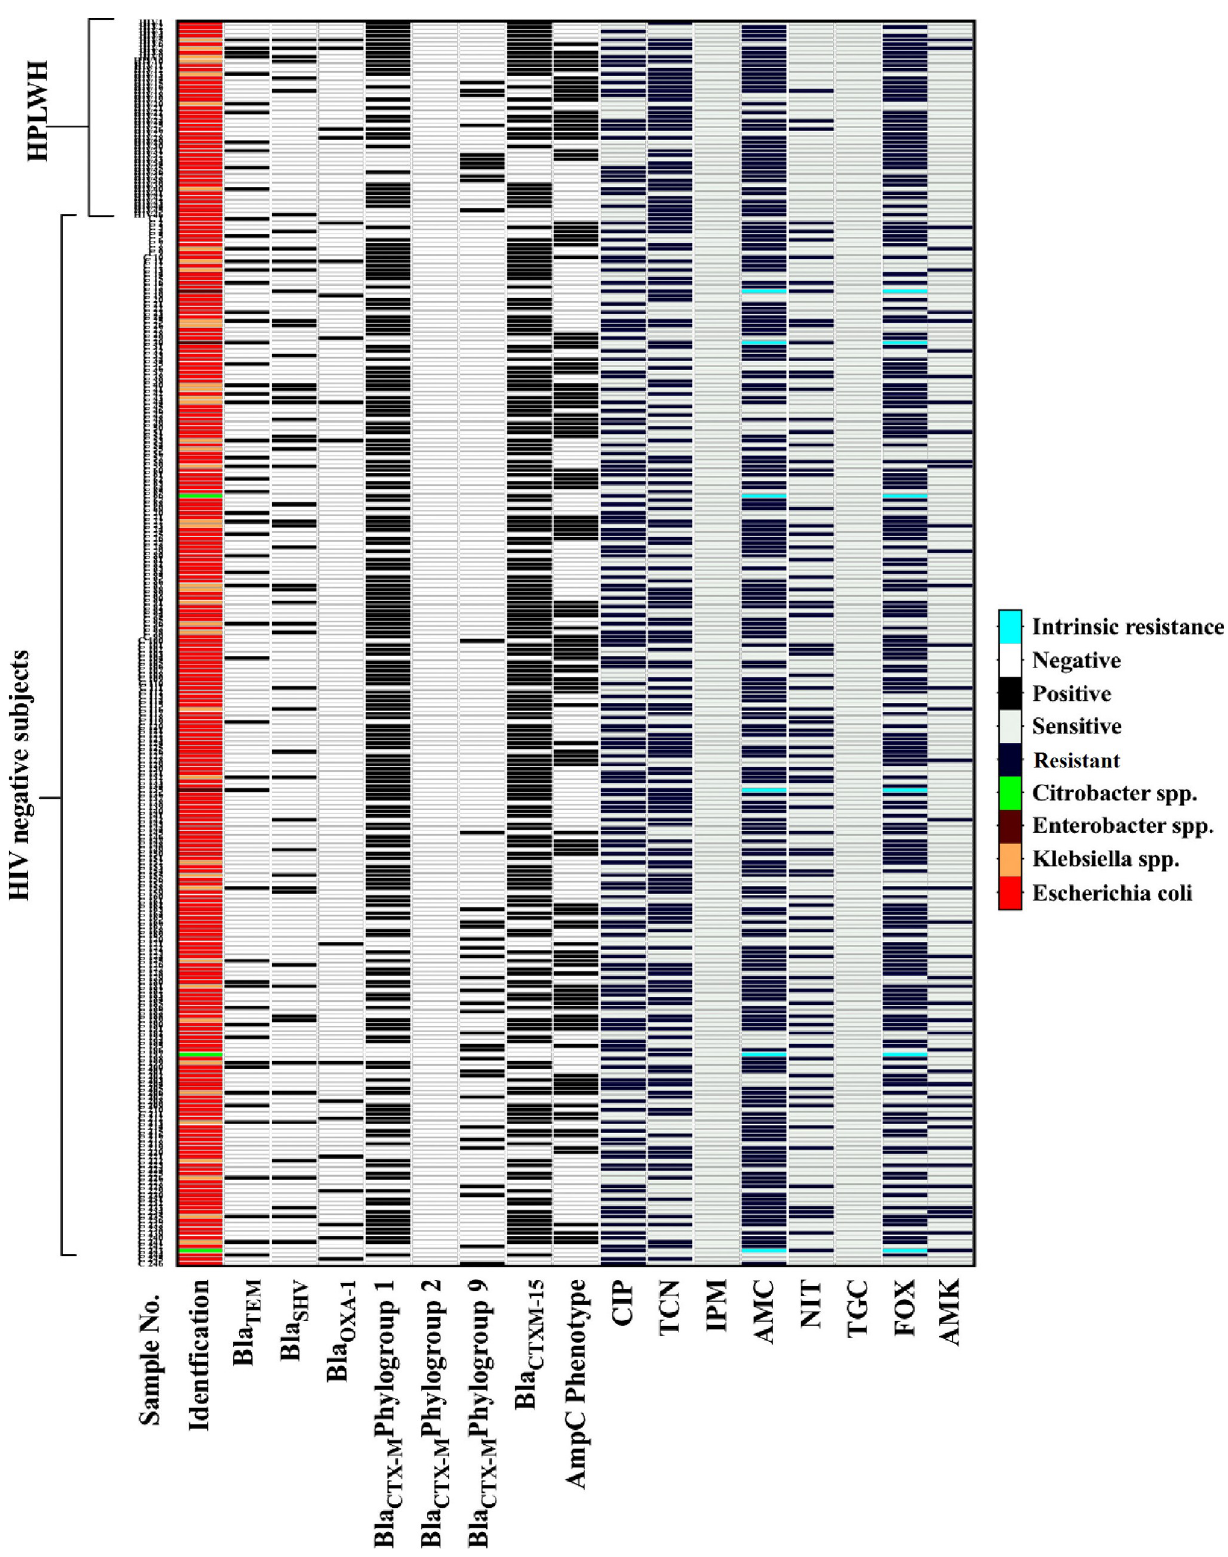
Fig 2. Antibiotic susceptibility and ESBL related genes identified in 292 ESBL producing isolates.